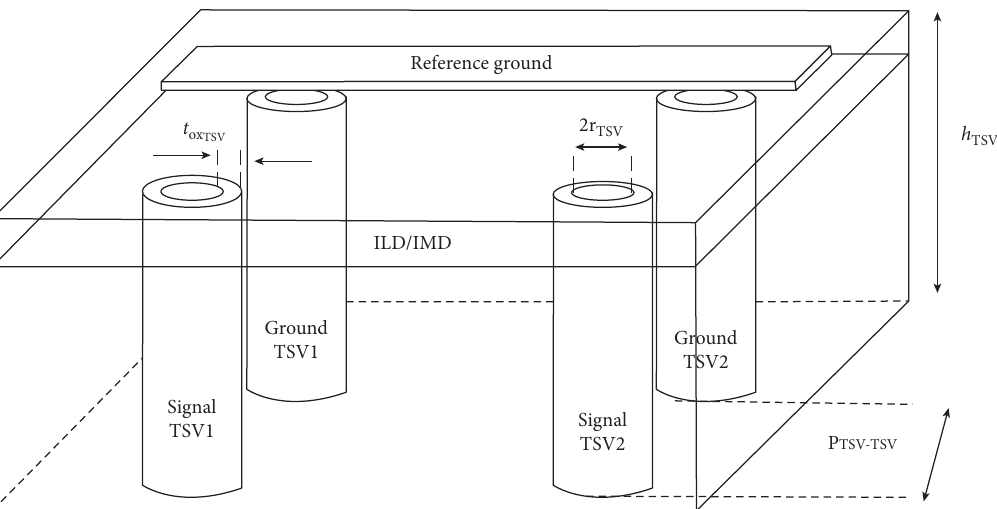
Figure 3: Structure of the TSV-TSV coupling